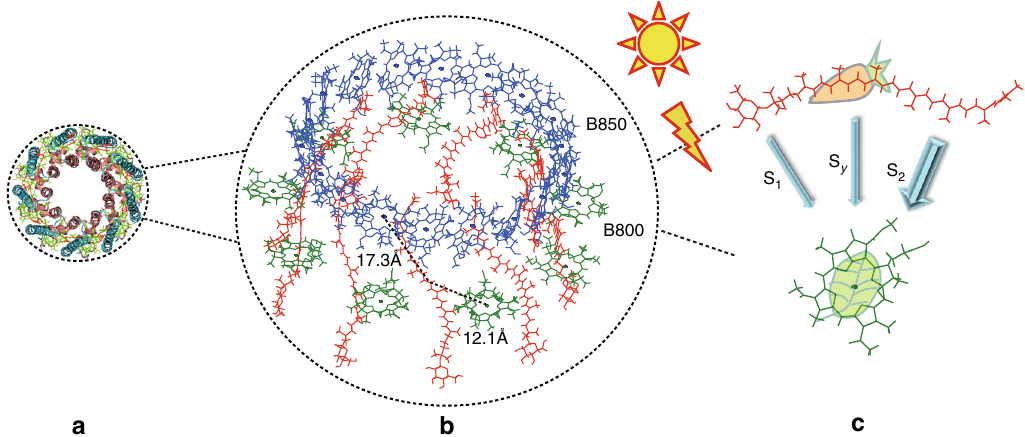
Fig. 2 Structure of Rps. acidophila . a Top view of the structure of light-harvesting complex II in Rps. acidophila . b Enlarged view of carotenoids and chlorophylls in a . For a better distinction, carotenoids, the nine B800 chlorophylls, and the eighteen B850 chlorophylls are depicted in red , green , and blue , respectively in b . After these antenna pigments absorb light, carotenoids transfer energy to chlorophylls B800 and B850, mainly through the S 2 state, partly through the S y and S 1 states as illustrated in c